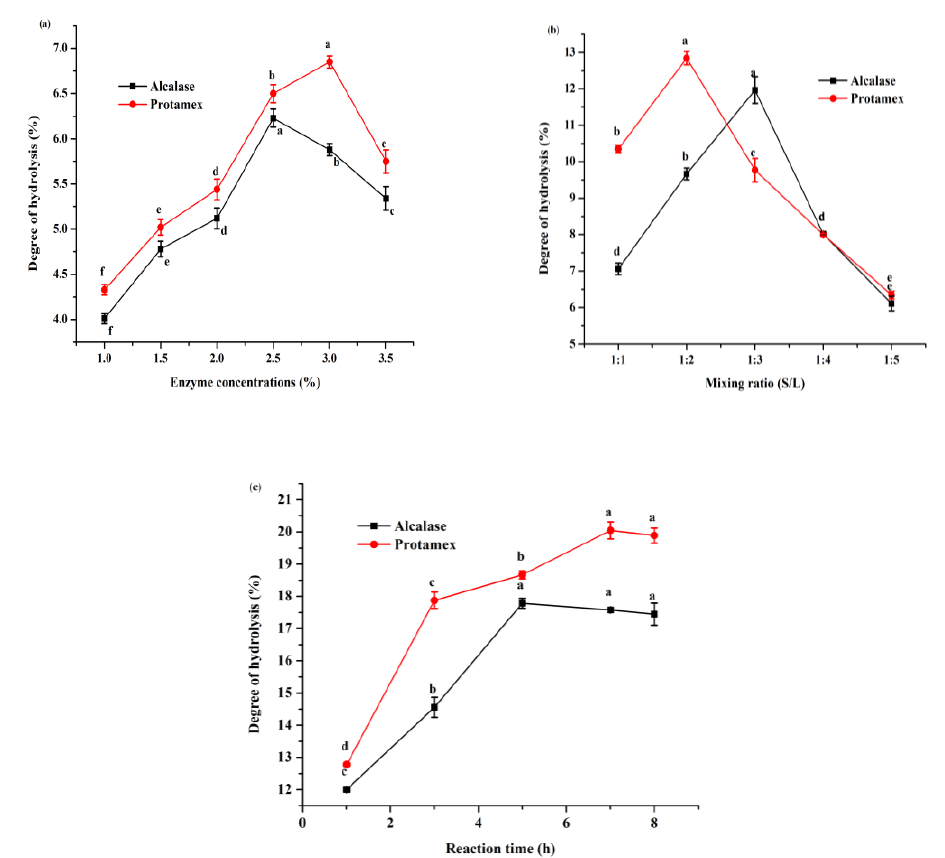
Figure 1. Effects of different conditions on degree of hydrolysis: ( a ) enzyme-to-substrate ratio, ( b ) sample-to-buffer ratio (S/L), and ( c ) time of incubation. Data are expressed as mean ± S.D. for n = 3. Different small letters within each assay indicate significant differences ( p < 0.05).